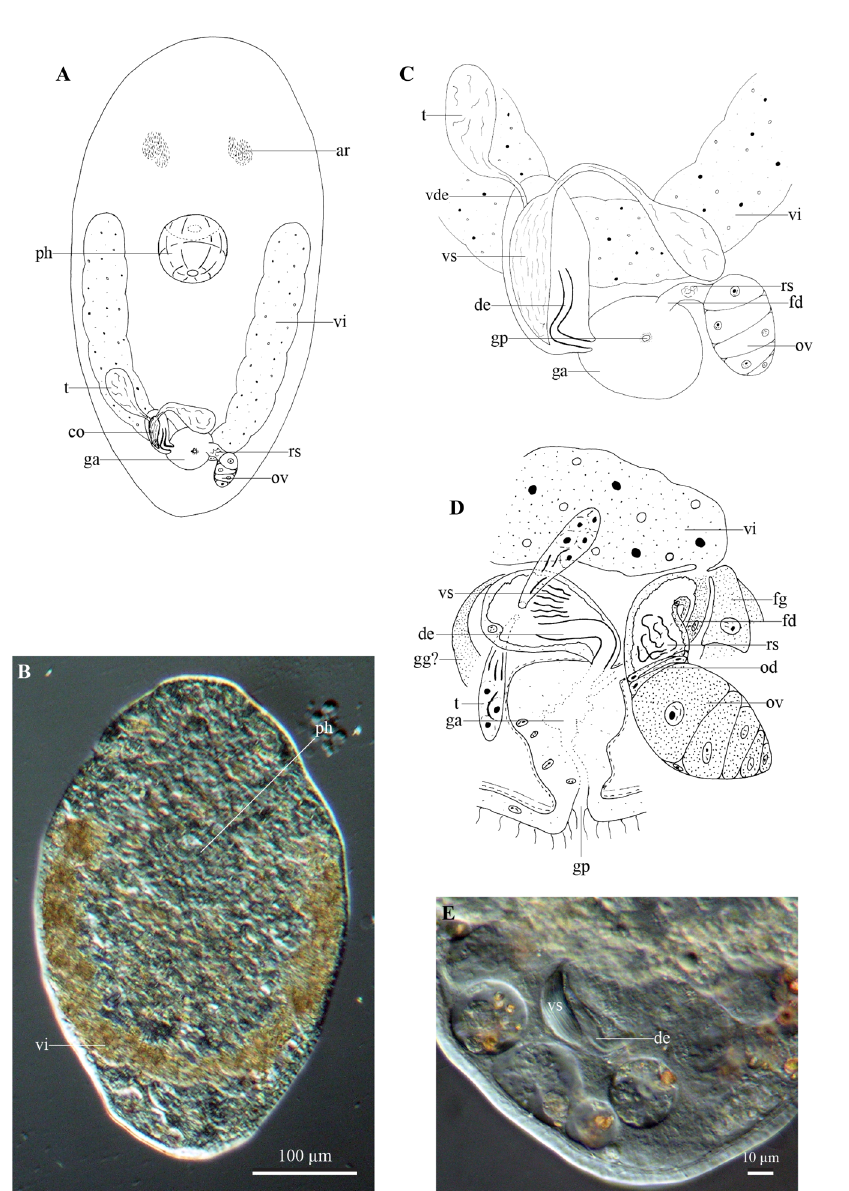
Fig. 5. Bryoplana belgica Houben, Proesmans & Artois sp. nov. A . Internal organisation of a